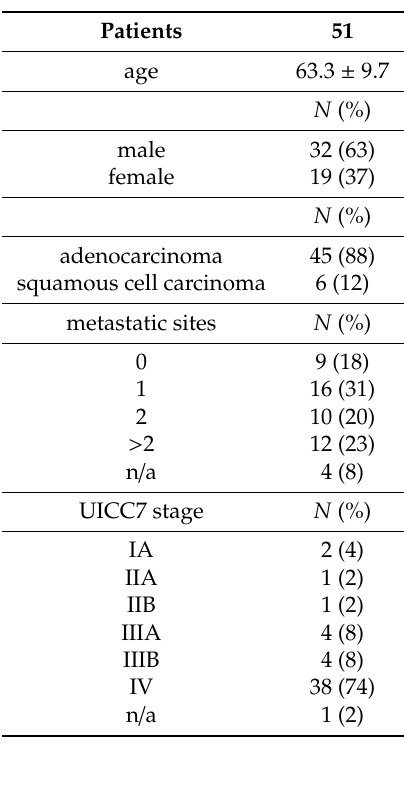
Table 1. Characteristics of the cohort.